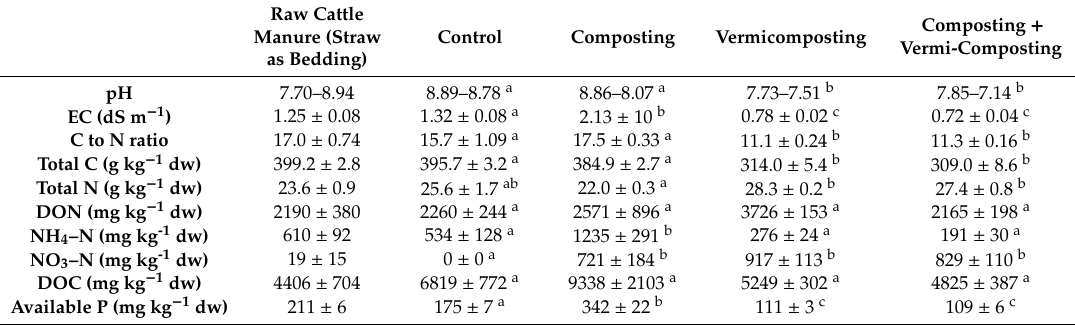
Table 5. Physicochemical and biochemical properties of raw cattle manure and substrates produced by di ff erent treatments: incubation under field conditions for 15 days (control), active phase of composting (composting), vermicomposting, and composting with subsequent vermicomposting (composting + vermicomposting)